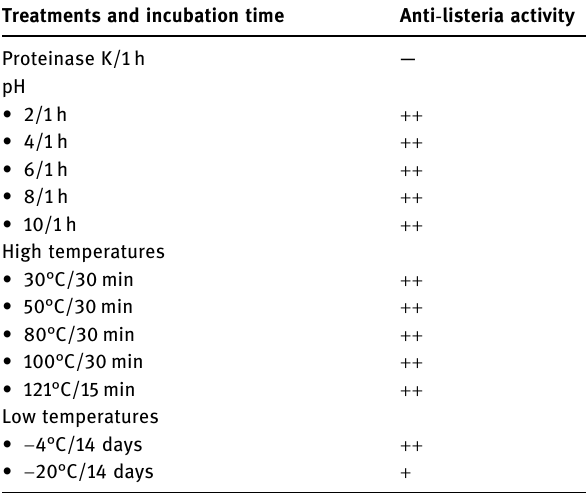
Treatments and incubation time